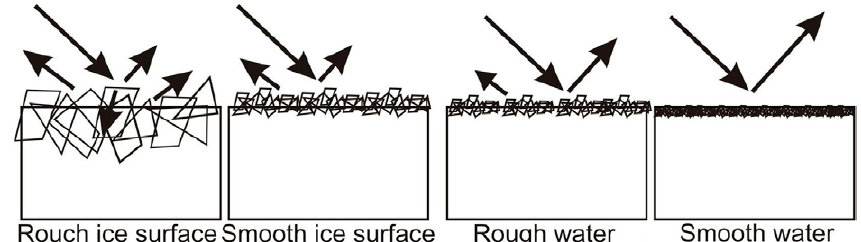
Figure 3. Relationship between ice surface and strength of the backscatter signal (Based on Unterschultz et al.,